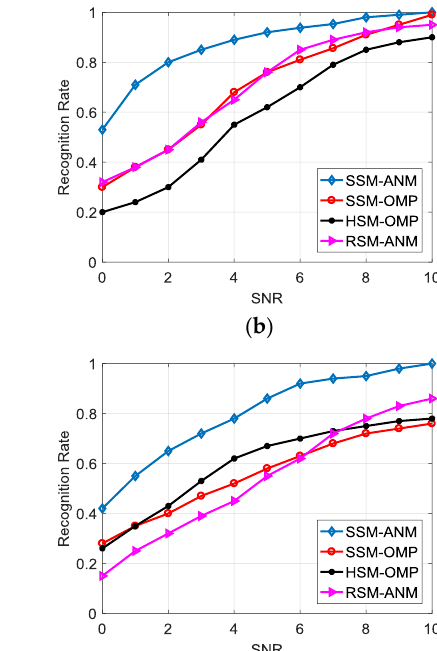
( d ) Figure 8. Recognition performance comparison in different SNRs. ( a ) Type A; ( b ) Type B; ( c ) Type C; ( d ) Type D. Next, we consider the performances of the four methods in extended CPI, where Figure 9